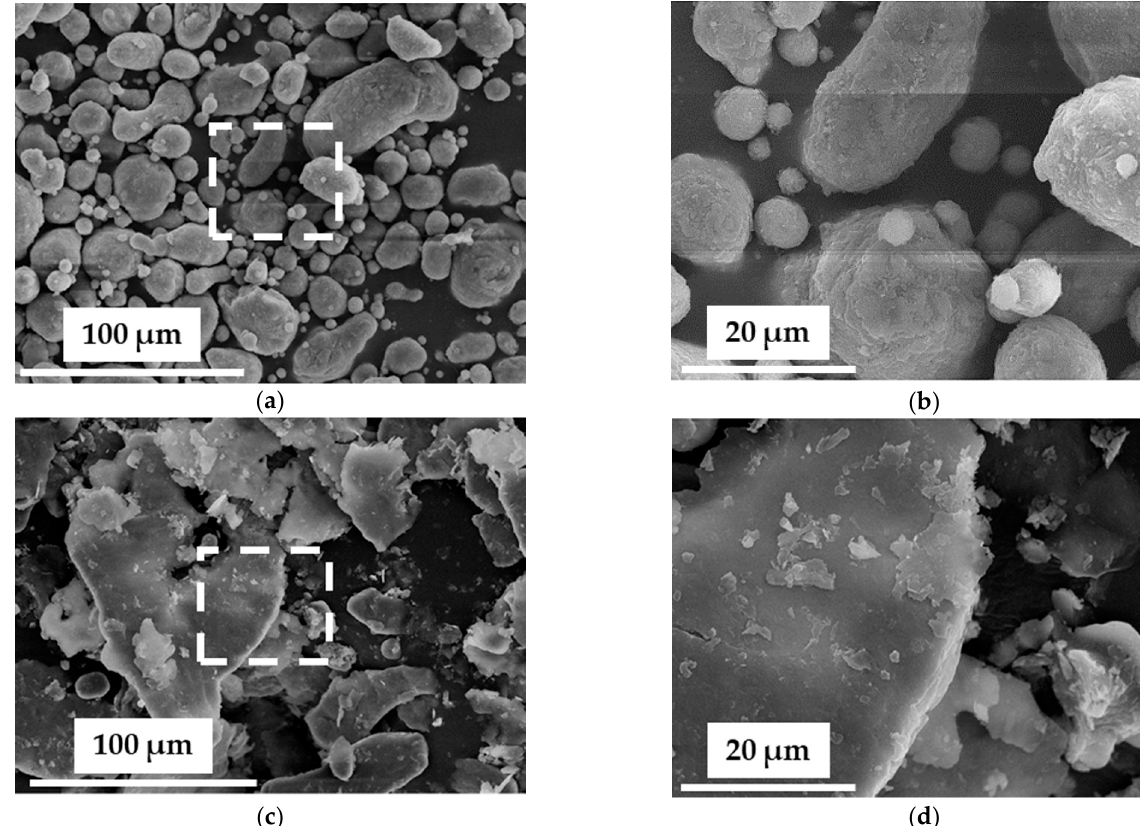
Figure 2. FESEM images of the powders: ( a ) AA7075 (as-received powder); ( b ) higher magnification of the boxed area in ( a ); ( c ) AA7075-M (milled powder); ( d ) higher magnification of the boxed area in ( c ).